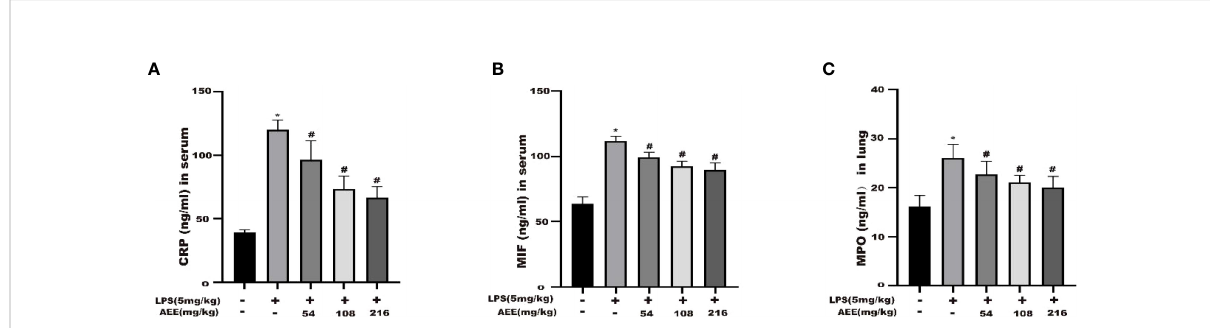
FIGURE 6 Effect of AEE on concentrations of CRP (A) , MIF (B) in serum, MPO (C) in lung tissue. Values are presented as the means ± SD where applicable ( n = 8). * P < 0.05 compared to control group, # P < 0.05 compared to LPS group.